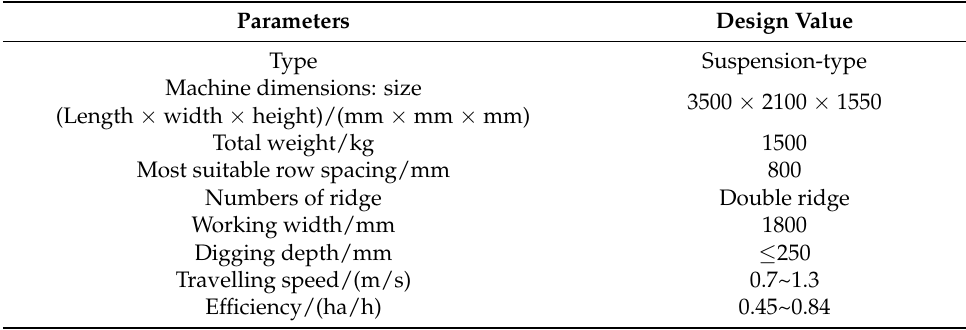
Figure 2. Peanut digger-inverter: 1. Depth limiting roller 2. V-shaped digging shovel 3. Vines guide rod 4. Rear wheel 5. inverting roller 6. Collecting plate 7. Inverting rod 8. Harrow teeth 9. Back loop conveyor chain 10. Frame 11. Transmission assembly. Table 1. Structural parameters and technical parameters of peanut digger-inverter .